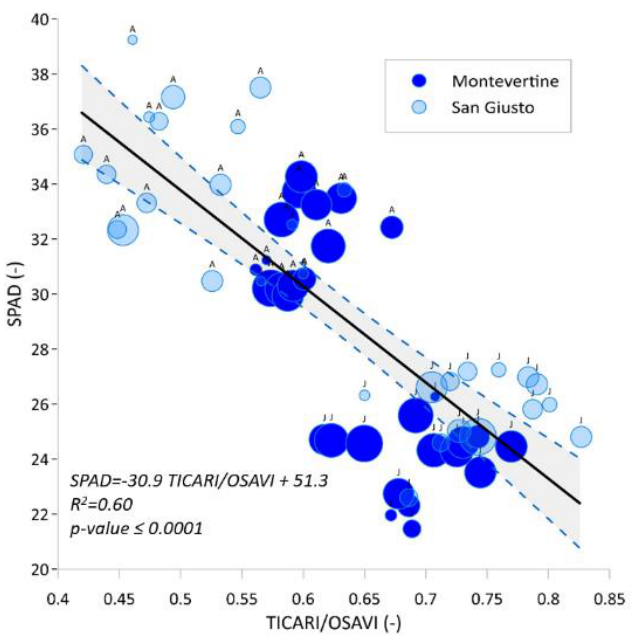
Figure 8. Correlation between TCARI/OSAVI and SPAD acquired on 16 June (J) and 03 August (A). The size of the bubble is proportional to the soil gravel content.